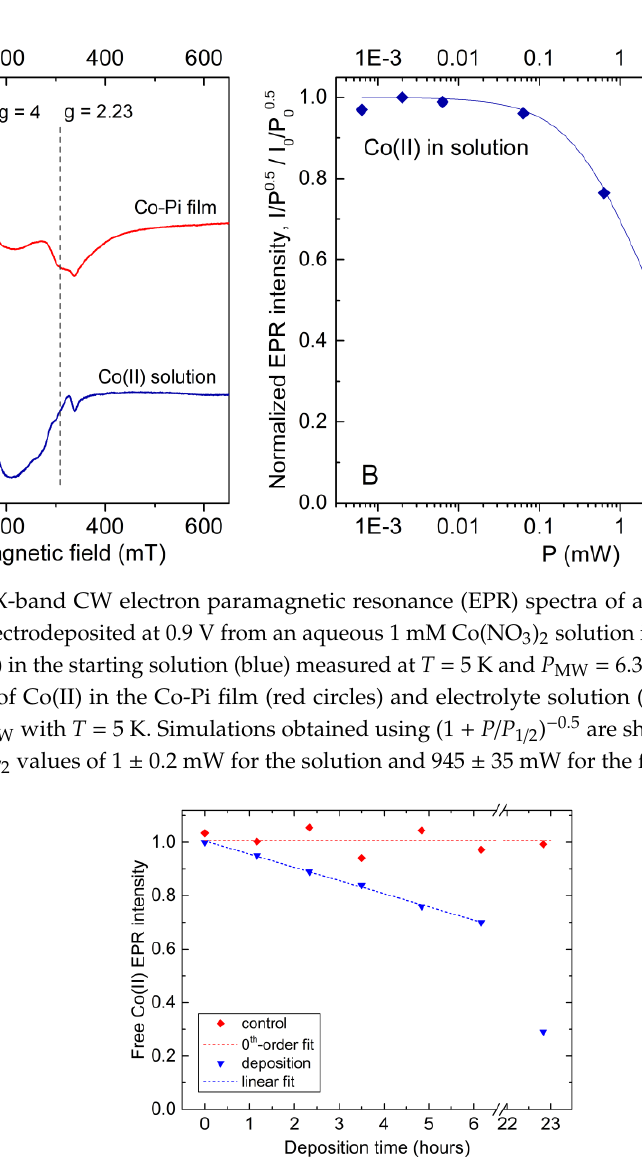
Figure 2. EPR intensity of free Co(II) in the electrolyte solution as a function of the electrodeposition duration (blue triangles) and in control solution (red diamonds). The blue dashed line represents a linear fit of the Co(II) intensity change during the first 6 h of deposition (if interpolated further, the linear fit reaches zero after approximately 20 h); red dashed line shows a zeroth-order polynomial fit of the control solution EPR intensity.